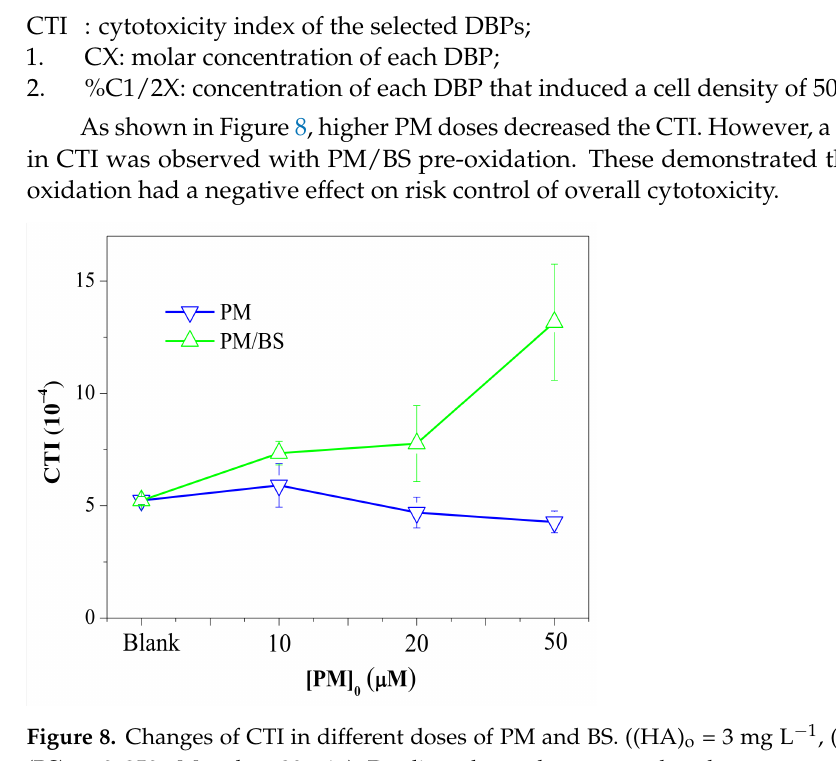
Figure S3: The fluorescence excitation–emission matrices in different molar ratio of PM and